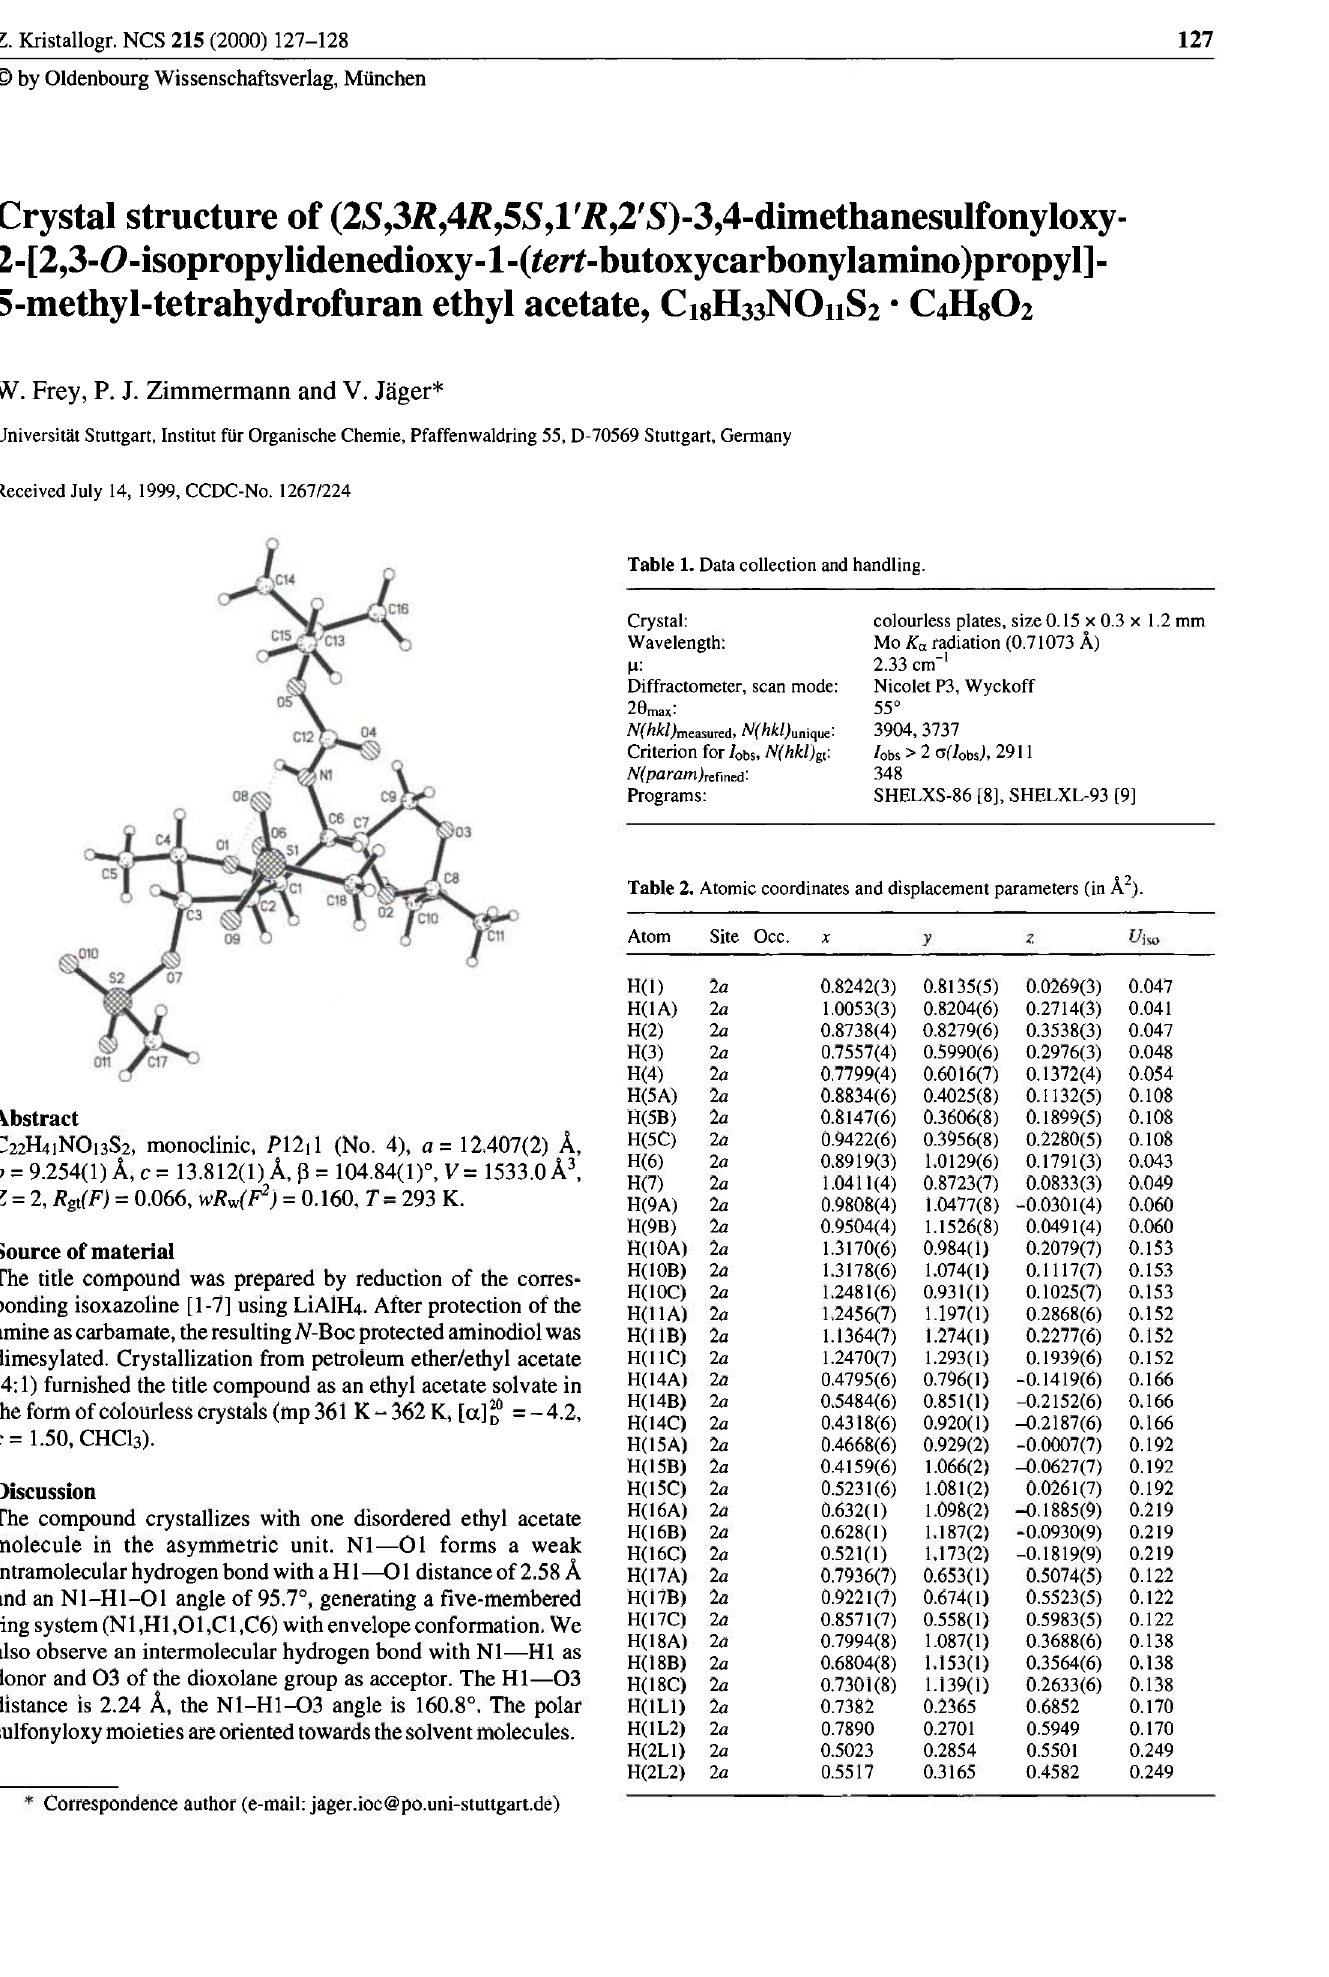
Table 1. Data collection and handling.